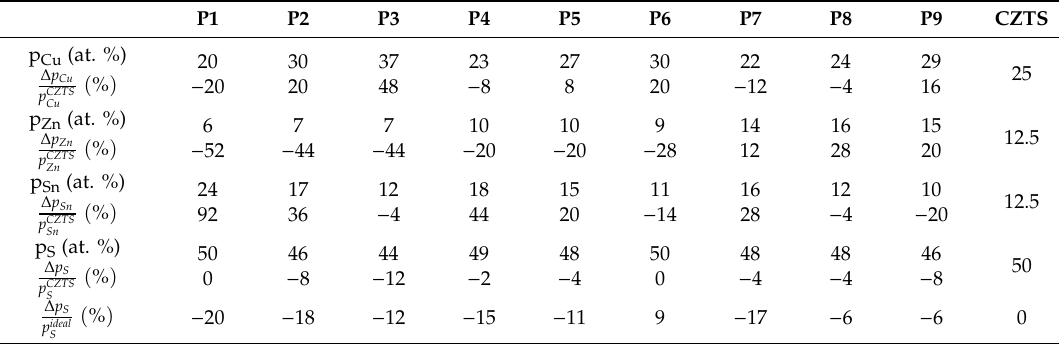
Table 1. The average chemical composition of the annealed Cu 2 S–ZnS–SnS 2 thin film samples.